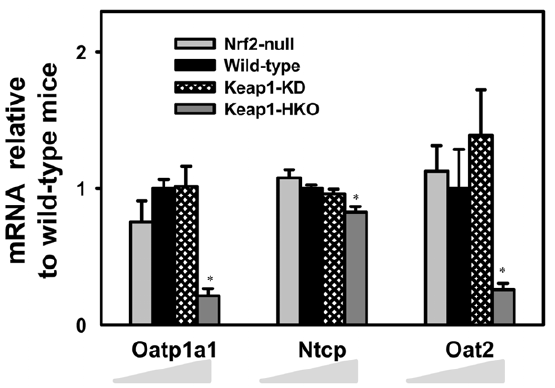
Figure 1. Messenger RNA expression of uptake transporters in a ‘‘gene dose-response’’ model. Data of Nrf2-null, Keap1-KD, and Keap1-HKO mice are normalized by the value of wild-type mice and presented as Mean 6 S.E.M. of three mice per group. Asterisks (*) indicate statistically significant differences from wild-type mice (p , 0.05).